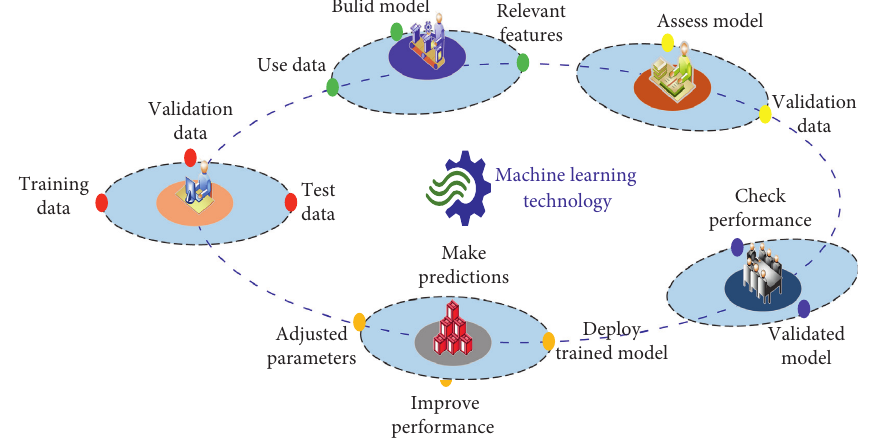
Figure 1: The process of machine